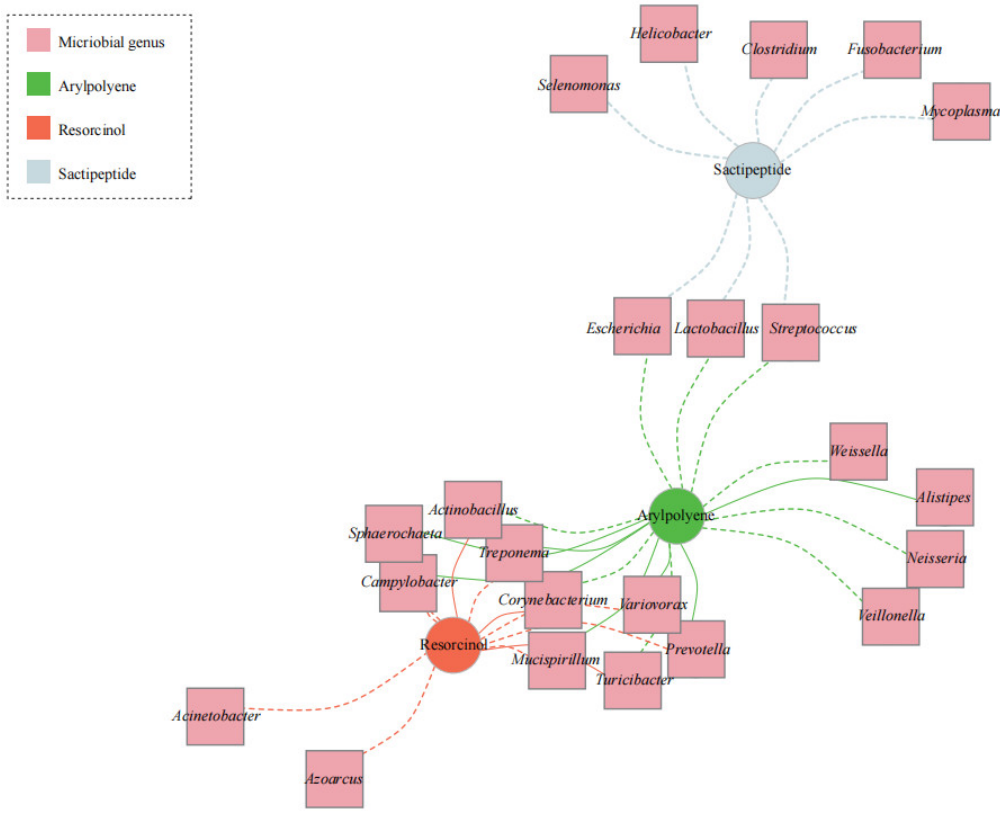
Figure 3. A network integration of intestinal microbiome and secondary metabolite genes. A positive correlation between nodes is indicated by the solid line, and negative correlation by the dashed line. The circles represent metabolites, and the pink squares represent genera with significant differences by Spearman’s rank correlation coefficient more than 0.5 and probability value less than 0.05.